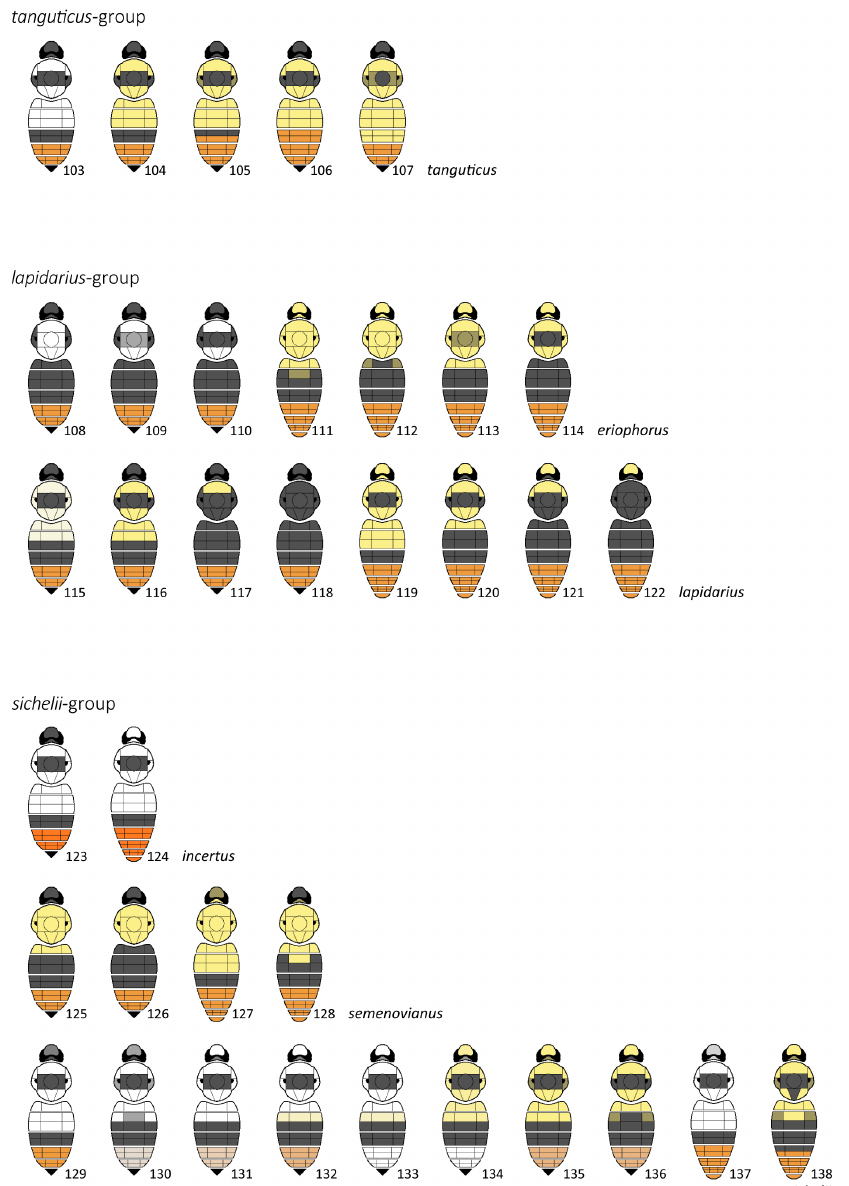
Figs 103–138. Simplified diagrams for the colour patterns of the hair on the dorsum for the species from the integrative analysis. The dorsum is divided into regions, each of which shows only the predominant or most apparent colour for that region using a simplified colour palette, with olive indicating a mixture of black and yellow hair, and grey indicating a mixture of black and white hair. The tanguticus -group